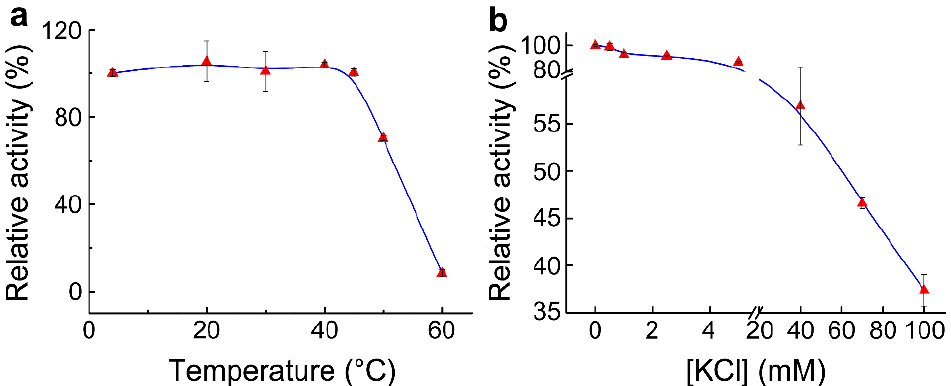
Figure 4. The thermostability of Adk and the inhibition of KCl on Adk activity. ( a ) Effect of temperature on Adk activity; ( b ) effect of KCl concentration on Adk activity.